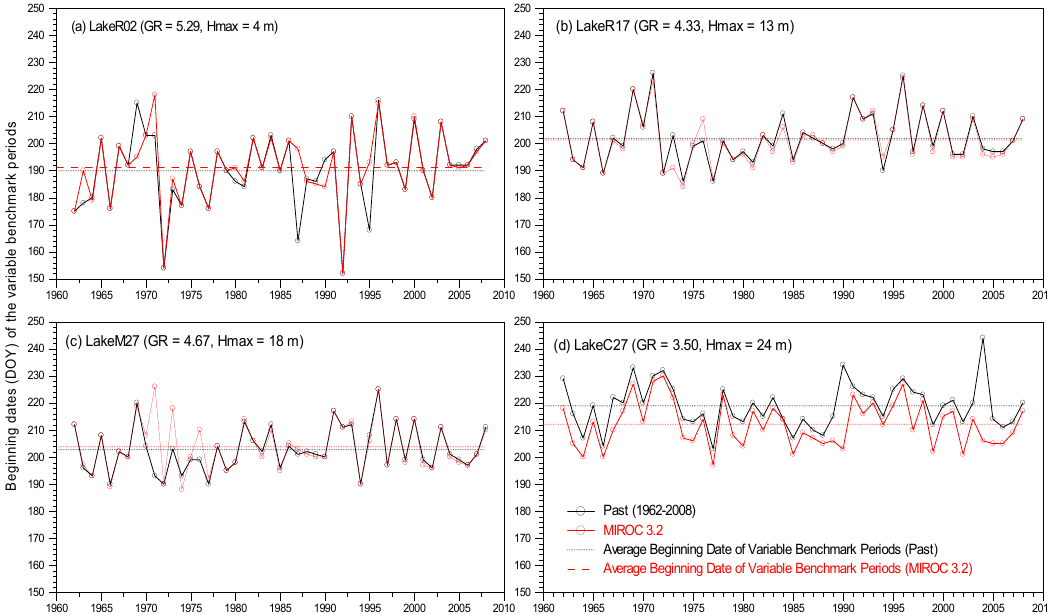
Figure 7. Time series of the beginning dates of the VB periods for ATDO3 VB in four types of virtual lakes ( a ) LakeR02, ( b ) LakeR17, ( c ) LakeM27, and ( d ) LakeC27 under the past climate conditions and MIROC 3.2 future climate scenario.